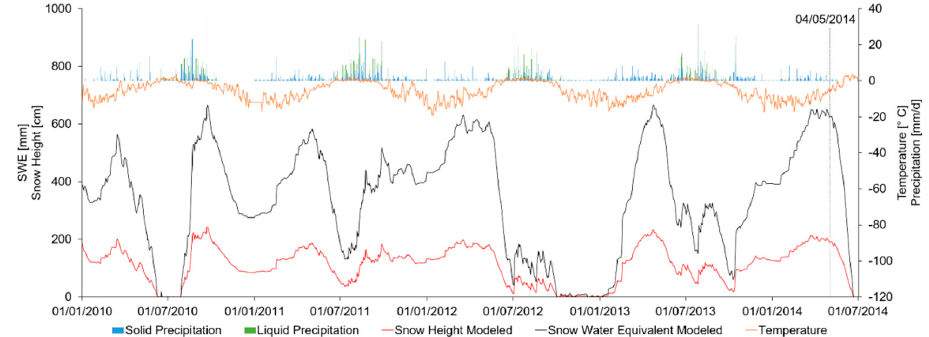
Figure 3. AWS West Khangri Nup. Snowpack simulation at EVK2CNR AWS station (5601 m asl) during 2010– 2014 (30 June). Upper part. Air temperature, partition between solid and liquid precipitation reported. Lower part. Simulated snow depth and snow water equivalent.